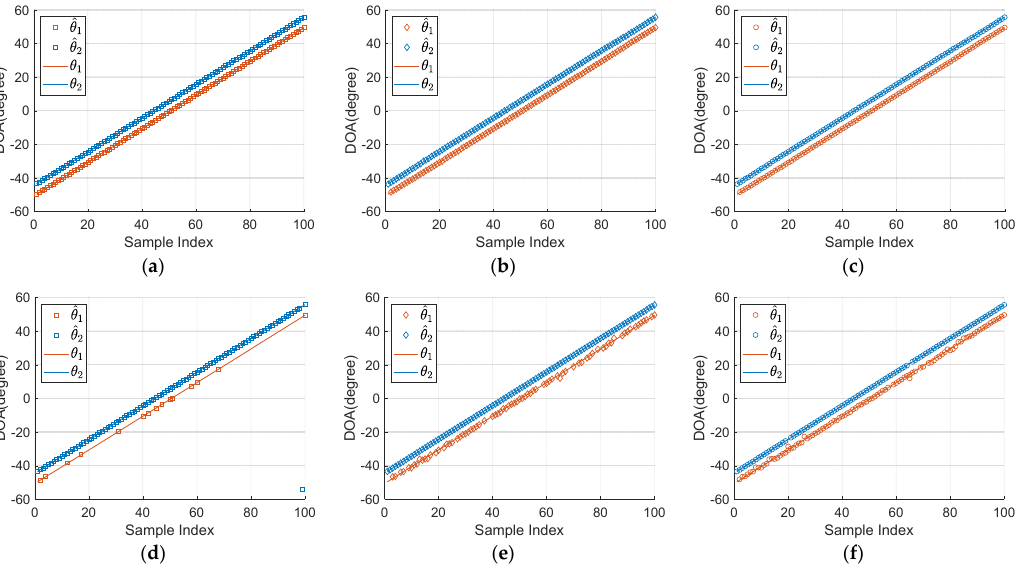
Figure 7. The DOA estimation of off-grid sources. First row: the SNR of the two sources is 15 dB. Second row: the SNR of two sources is 10 dB and 18 dB. ( a ) DCN, Acc:100%, RMSE:0.061, ( b ) DNN- NSW, Acc:100%, RMSE:0.149 ( c ) DNN-SW, Acc:100%, RMSE:0.128 ( d ) DCN, Acc:15%, RMSE:0.129, ( e ) DNN-NSW, Acc:78%, RMSE:0.396 ( f ) DNN-SW, Acc:97%, RMSE:0.262.